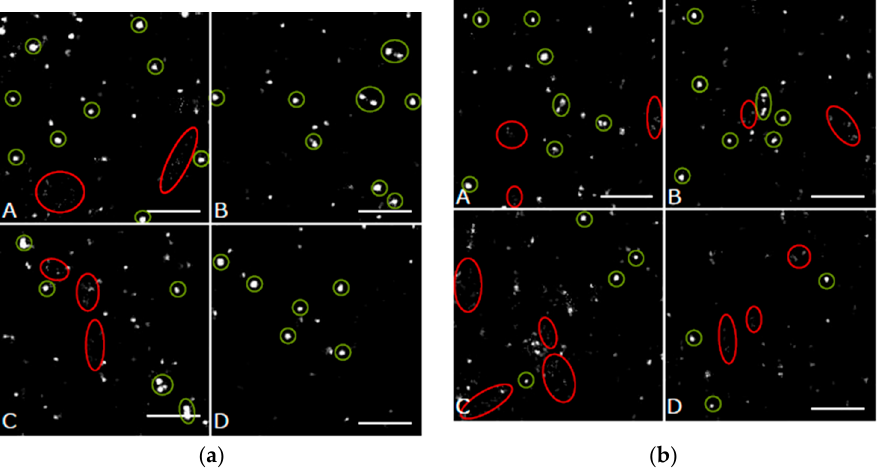
Figure 9. Images of Cx43 molecules in BJ cells obtained from the coordinate matrices after SMLM. The clustered points (encircled in green) represent points contributing to the peak in Figure 8a,b. The dispersed points (encircled in red) represent points contributing to the right “tail” of the curves in Figures 8 a,b. ( a ) peripheral regions, ( b ) perinuclear regions. A = untreated; B = irradiated; C = NRG1 treatment; D = trastuzumab treatment. Scale bar 1 µm.